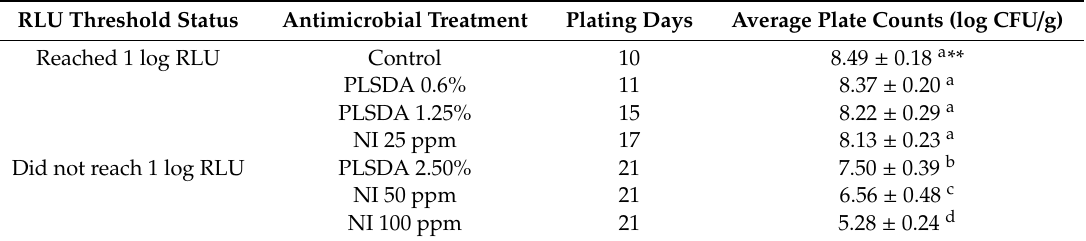
Table 2. The number of days to reach the threshold of detection for antimicrobial treatments targeting L. monocytogenes Xen19 *.